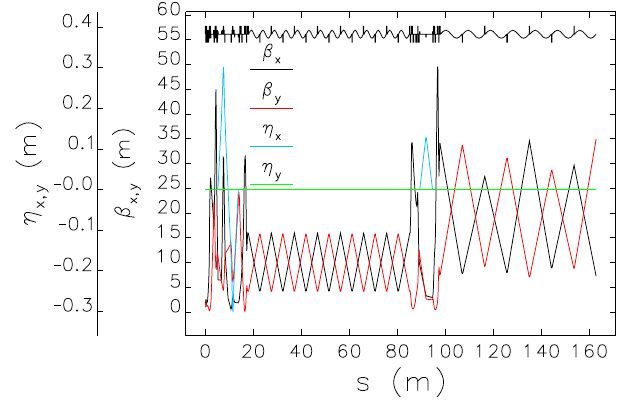
FIG. 4. Start-to-end TWISS parameters, a beam energy from 50 MeV to 7 GeV. Black curve denotes horizontal beta function, red curve vertical beta function, blue curve horizontal dispersion function, and green curve horizontal angular dispersion